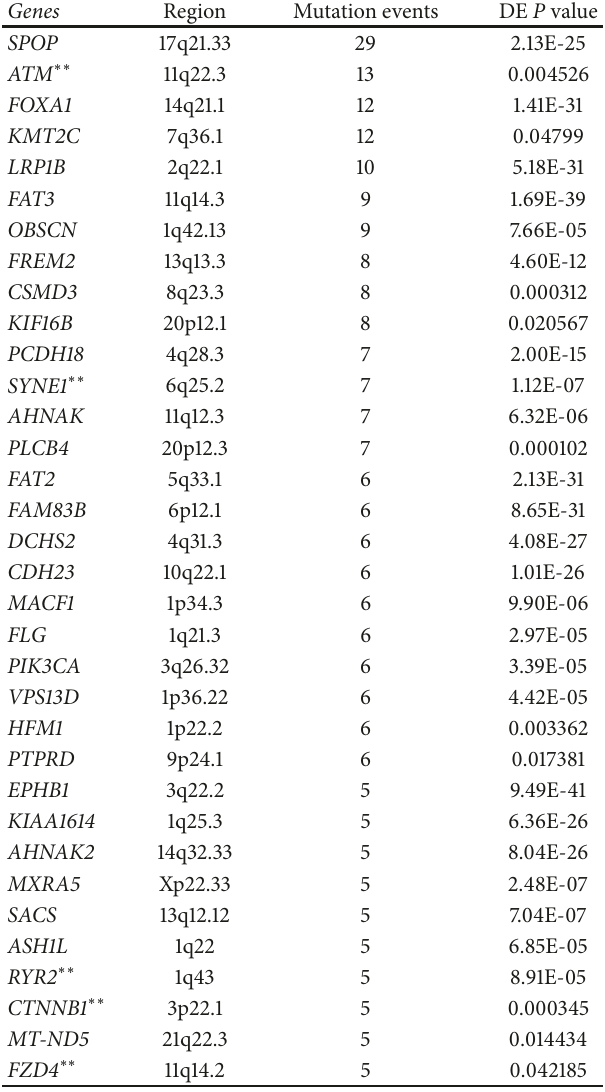
Table 1: List of the 34-gene signature containing the most highly somatically mutated genes ( ≥ 5 Mutation events) that were sig- nificantly differentially expressed between aggressive tumors and